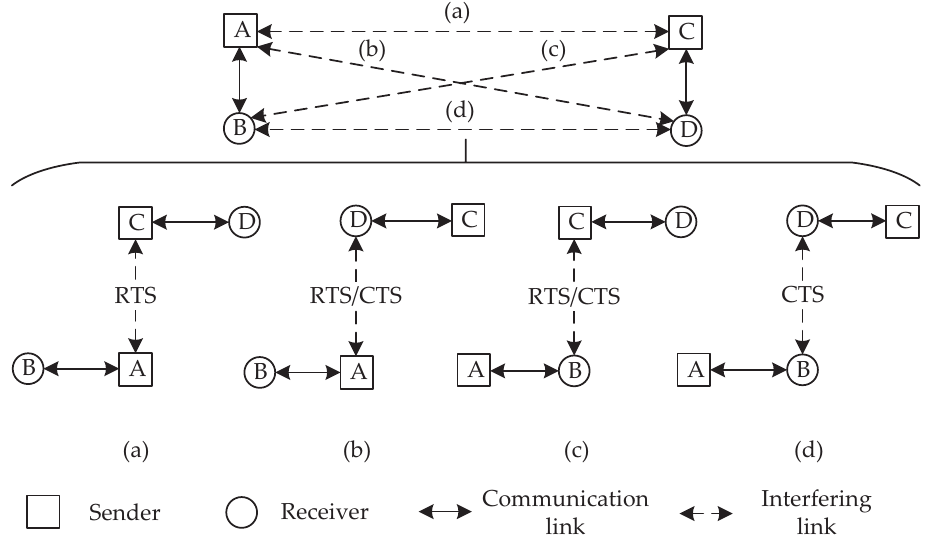
Figure 1. 4-node network topology. ( a ) C is the exposed transmit terminal of A. ( b ) D is the exposed receive terminal of A. ( c ) C is the hidden transmit terminal of A. ( d ) D is the hidden receive terminal of